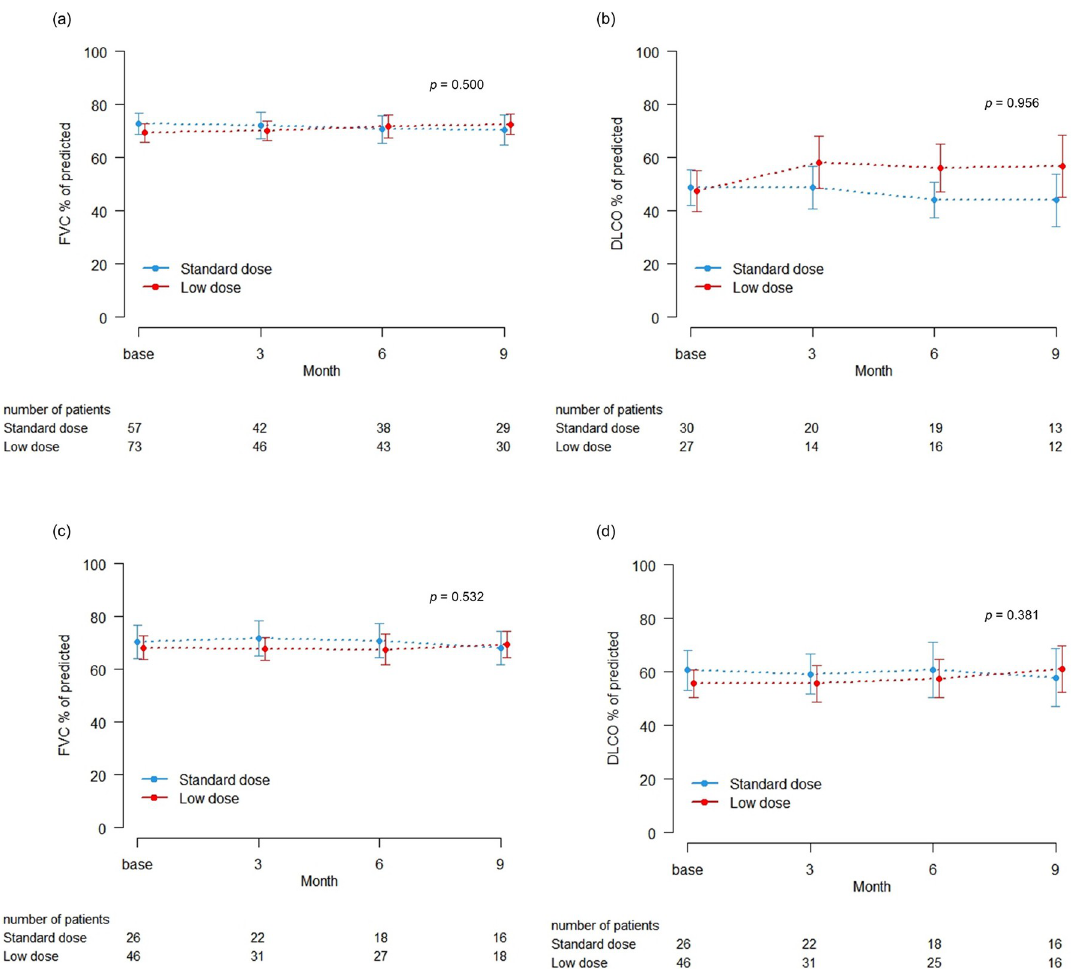
Fig 2. Changes in PFTs according to emphysema and pirfenidone dose. (a) Changes in FVC in patients with emphysema ( p = 0.500); (b) Changes in DLCO in patients with emphysema ( p = 0.956); (c) Changes in FVC in patients without emphysema ( p = 0.532); (d) Changes in DLCO in patients without emphysema ( p = 0.381). Abbreviations: DLCO, diffusing capacity for carbon monoxide; FVC, forced vital capacity.